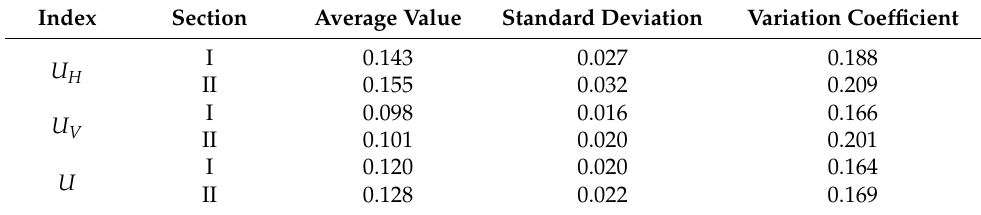
Table 6. Statistics of component distribution homogeneity of detection